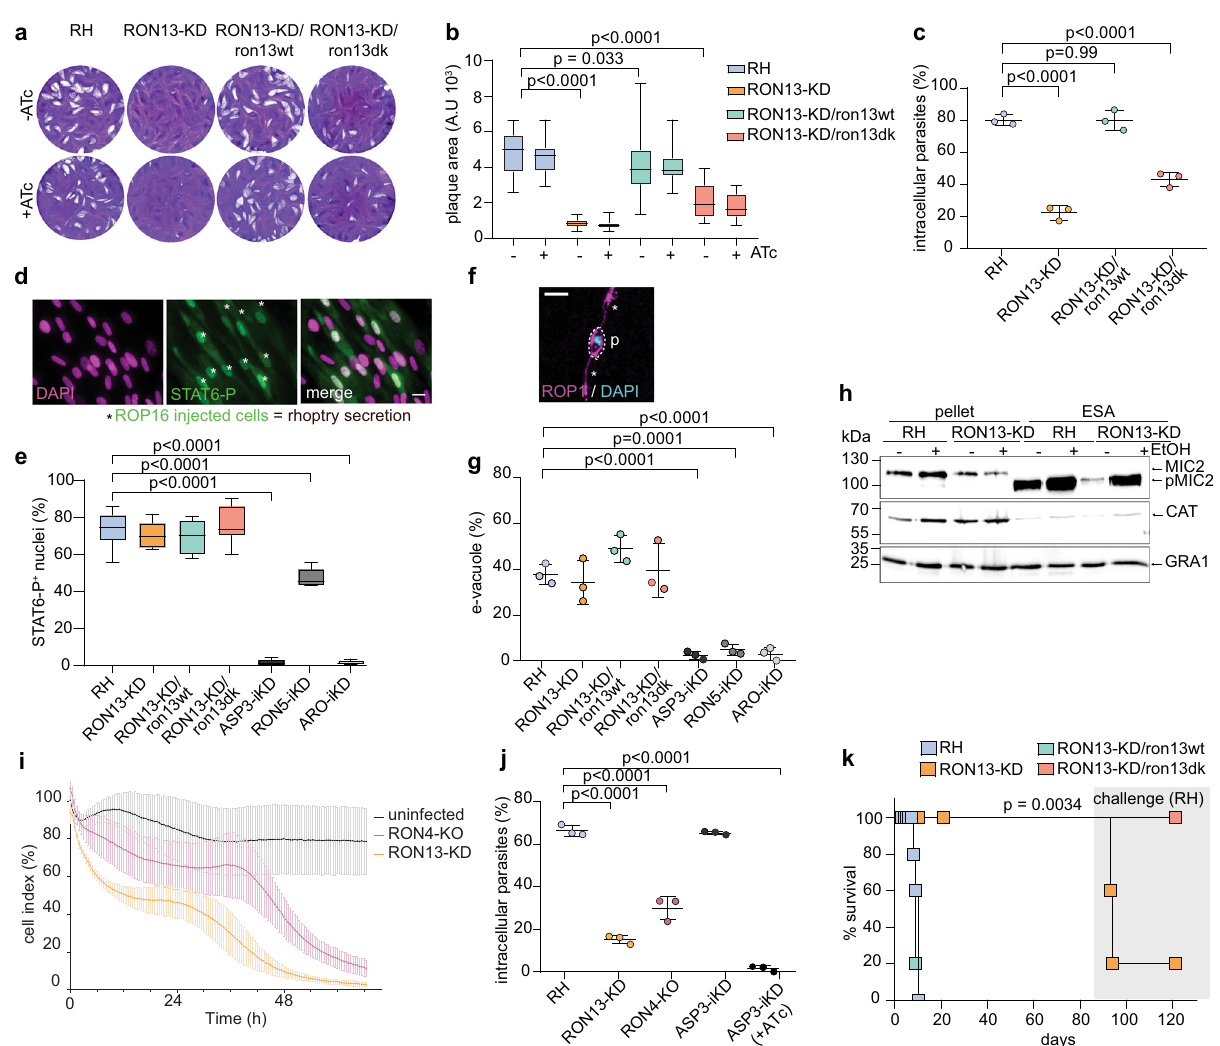
Fig. 5 RON13 is critical for invasion. a Plaque assays of different parasite strains (±ATc) showing that depletion of RON13 impairs the parasite lytic cycle (no plaque), a phenotype that is fully rescued by complementation with an active RON13 kinase. Image representative of three biologically independent experiments. b Quanti fi cation of plaque assays for RH, RON13-KD, and complemented RON13-KD/ron13wt or RON13-KD/ron13dk parasites (±ATc). Data are presented as box and whiskers plot (median with min to max, n = 3 biologically independent experiments). Statistical signi fi cance was assessed by a two-way ANOVA signi fi cance with Tukey ’ s multiple comparison. c Invasion assay ( + ATc) showing a strong invasion defect when RON13 kinase is absent or inactive P value were determined by a one-way ANOVA signi fi cance with Tukey ’ s multiple comparison. (Mean ± SD; n = 3 biologically independent experiments). d IFA showing a representative fi eld of the rhoptry secretion test using phosphor-STAT6 as a readout with fi broblast nuclei stained in DAPI (magenta) and ROP16-injected cells stained with anti-phospho-STAT6 (STAT6-P) antibody (green, asterisks). Scale bar = 25 μ m. Image representative of three biologically independent experiments. e Phospho-STAT6 assays assessing the ability of the parasite to secrete the rhoptry protein ROP16 into the host cell that phosphorylates host STAT6 in the nucleus. Data are presented as box and whiskers plot (median with min to max, n = 3 biologically independent experiments). Statistical signi fi cance was assessed by a two-way ANOVA signi fi cance with Tukey ’ s multiple comparison. f Representative IFA of the e-vacuole assay to assess rhoptry secretion when invasion is blocked by cytochalasin D. A parasite (p) secreting e-vacuoles ROP1 + (asterisks) is depicted. Parasite DNA is visualize using DAPI (blue). Scale bar = 5 µ m. Image representative of three biologically independent experiments. g E-vacuole assays assessing the ability of the parasites to secrete the rhoptry protein ROP1 into the host cell (mean ± SD; n = 3 biologically independent experiments). Statistical signi fi cance was assessed by a one-way ANOVA signi fi cance with Tukey ’ s multiple comparison. h Microneme secretion of extracellular parasites stimulated with 2% ethanol to assess the release of MIC2 in culture supernatant. pMIC2 processed MIC2, ESA excreted – secreted antigens. GRA1 is used as a control for constitutive secretion from dense granules. Samples derived from the same experiment and gels were processed in parallel. Image representative of three biologically independent experiments. i Kinetic assay representing the cell index of HFF infected with different parasite strains. (Mean ± SD; n = 3 biologically independent experiments). j Invasion assay showing that RON13-KD and RON4-KO parasites are defective in invasion. P values were determined by a one-way ANOVA signi fi cance with Tukey ’ s multiple comparison (mean ± SD; n = 3 biologically independent experiments). Statistical signi fi cance was assessed by a one-way ANOVA signi fi cance with Tukey ’ s multiple comparison. k Virulence of different strains in mice. Surviving mice at 84 days post infection were challenged with RH parasites (gray shaded). ( n = 5 biologically independent animals). P values were determined by a Mantel – Cox test. Source data are provided as a Source data fi